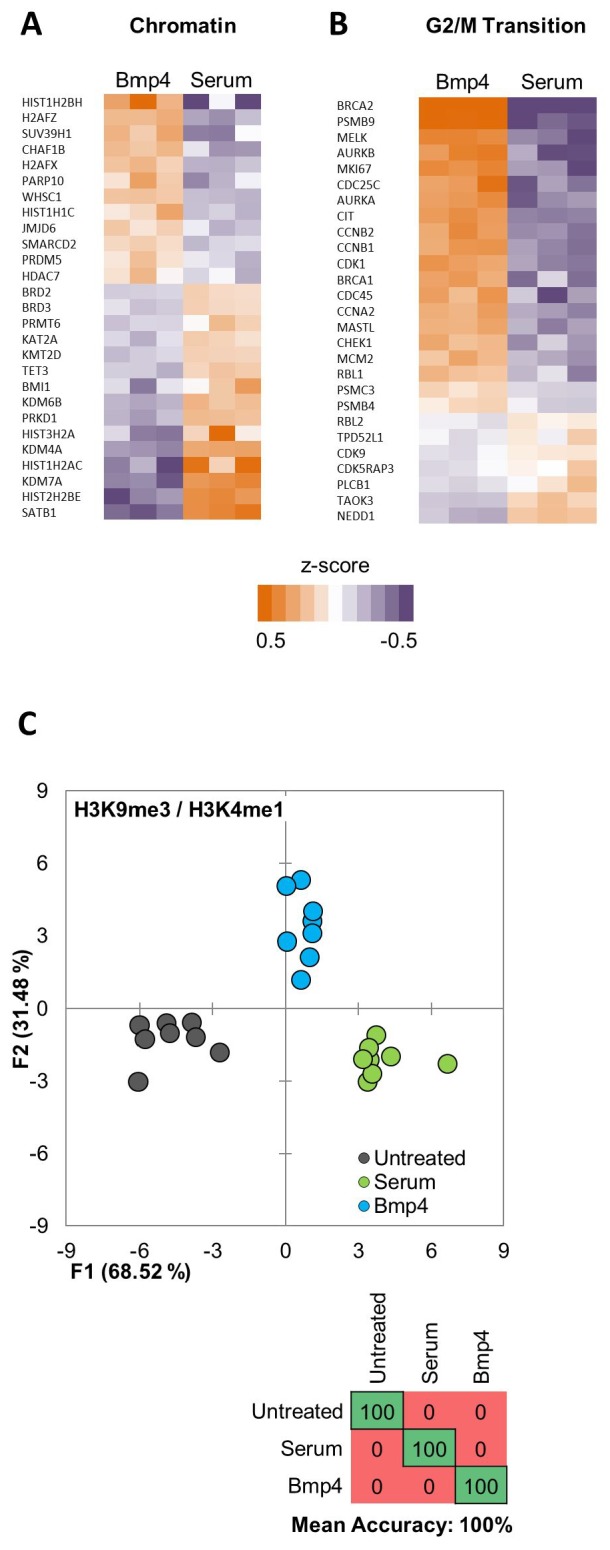
Serum and Bmp4 treatments induce distinct epigenetic and transcriptomic changes.(A, B) Heat maps showing differential expression of selected genes from Gene Ontology (GO) terms (A) chromatin-modification (GO:0006325) or (B) cell-cycle G2/M phase transition (GO:0044839). Expression levels (FPKM) are represented as z-score to highlight difference in levels of expression. (C) Quadratic discriminant analysis using texture features derived from images of untreated or 2 days serum- or Bmp4- treated GBM2, 101A, SK262 and 454 M cells (three replicates per cell lines per treatment) and stained for H3K27me3 and H3K27ac. Scatter plot depicting the first two discriminant factors for each cell population (two replicates per cell lines per treatment). Confusion matrix showing classification results for the discriminant analysis (test set: one replicate per cell line per treatment). Numbers represent the percent of correctly (diagonal) and incorrectly (off the diagonal) classified cell populations.